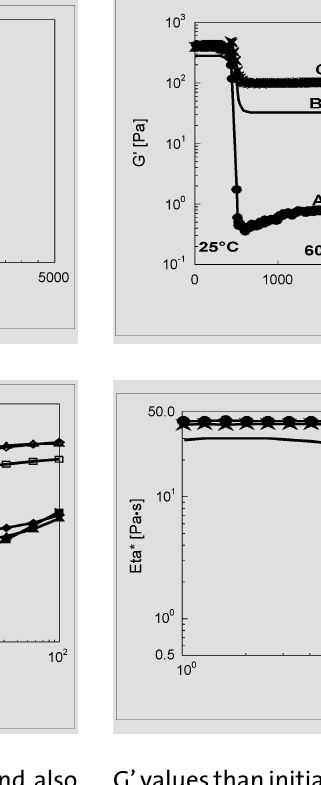
Figure 6 (left above): Temperature profile of tem- perature step test. Figure 7 (right above): G’ change in temperature step test from 25 to 60, then back to 25°C. Figure 8 (left below): Frequency dependence data at 25°C. Figure 9 (right below): h * versus stress plot at